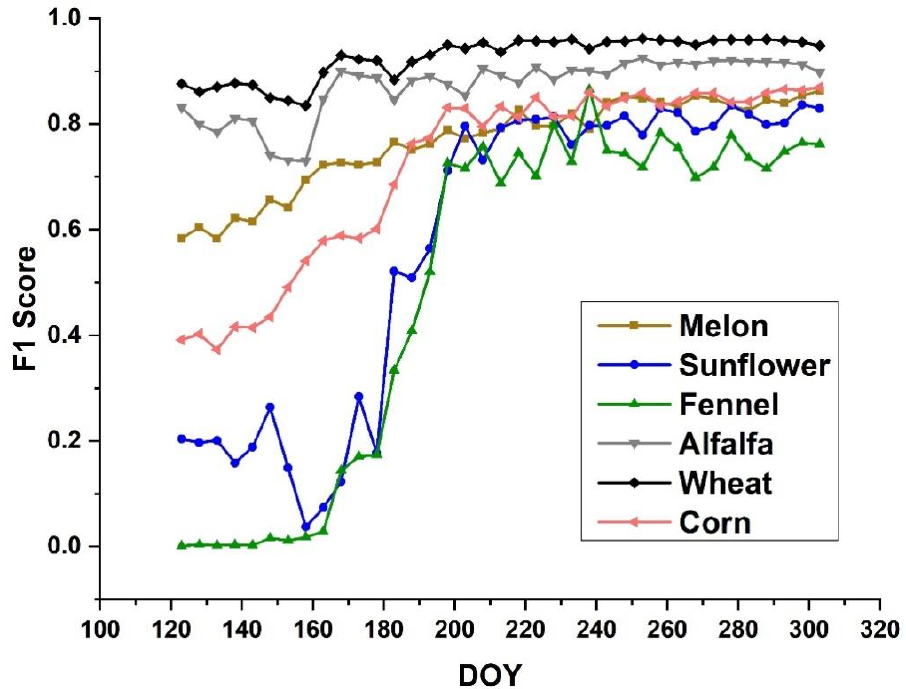
Figure 8. Changes in the F1 scores of the six crops based on the Conv1D network and time-series Sentinel-2 data with a 5-day interval.